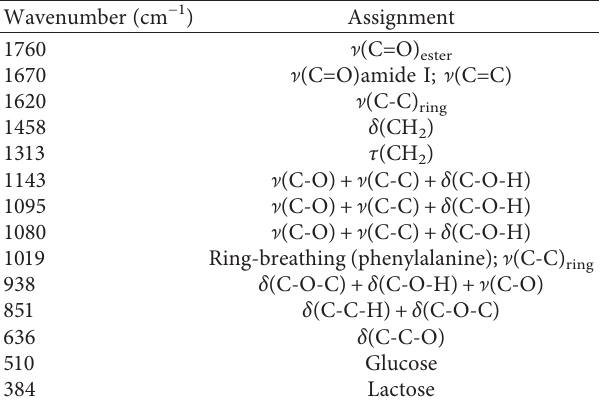
] , stretching vibration; δ , deformation vibration; τ , twisting